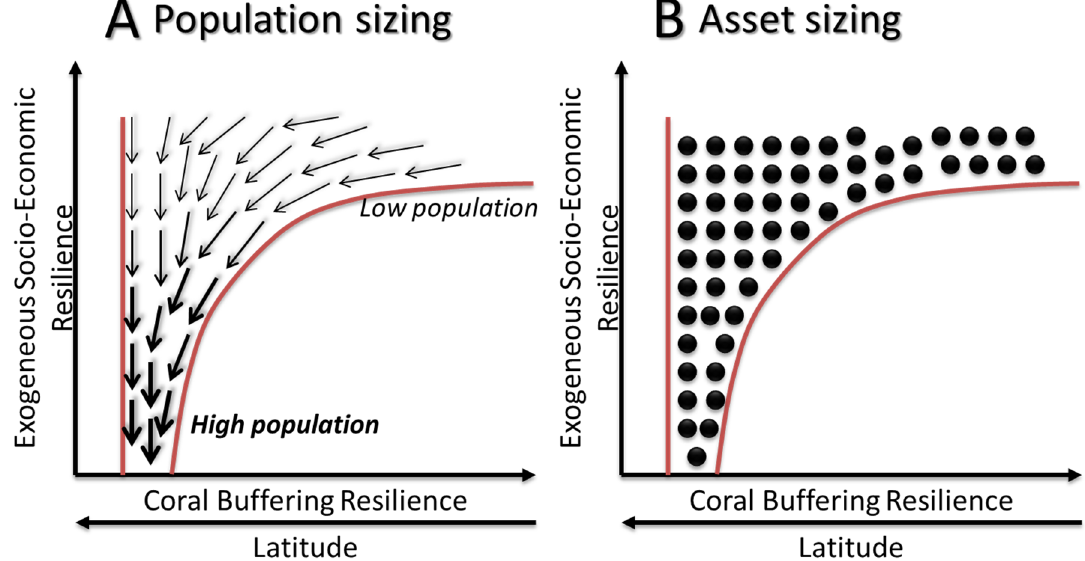
Figure 10. Conceptual interpretation of the SEE resilience bubble plot weighted by ( A ) the population amount and ( B ) the asset value ( i.e., land price in ¥ m − 2 ). The red lines symbolize the boundaries of the distribution; the thickness of the arrow is positively correlated with the population size; and the spatial uniformity of the circles represents the absence of correlation with the SEE